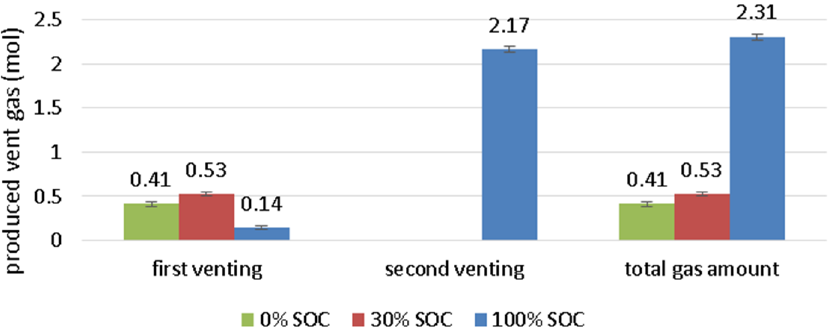
Figure 9. Produced vent gas amount in mol for 0% (green), 30% (red) and 100% SOC (blue) pouch cell at overtemperature experiments at first venting and second venting in comparison.